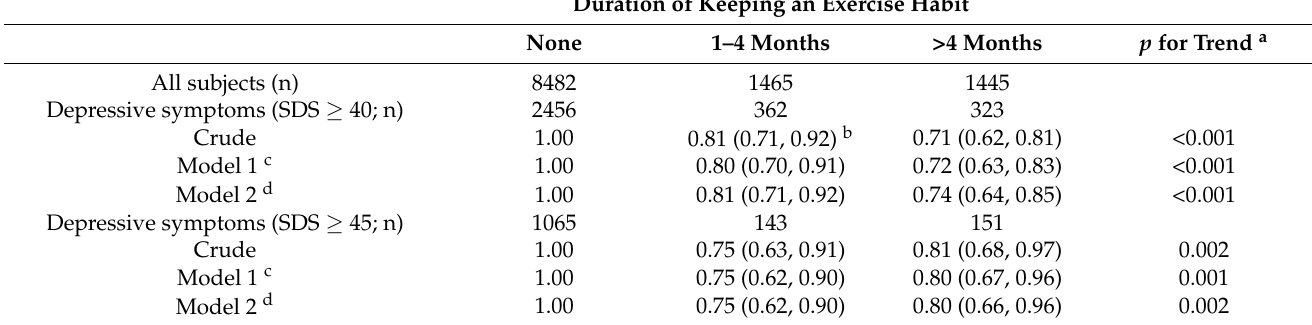
Table 2. Adjusted association for depressive symptoms according to categories of duration of keeping an exercise habit.